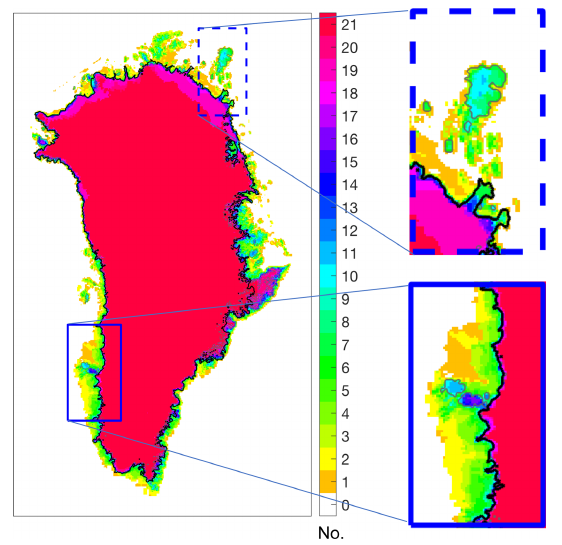
Figure 2. Common initial ice mask of the ensemble of models in the intercomparison. The colour code indicates the number of models (out of 21 in total) that simulate ice at a given location. Outlines of the observed main ice sheet (Rastner et al., 2012) and all ice- covered regions (i.e. main ice sheet plus small ice caps and glaciers; Morlighem et al., 2017) are given as black and grey contour lines, respectively. A complete set of figures displaying individual model results is given in the Supplement.